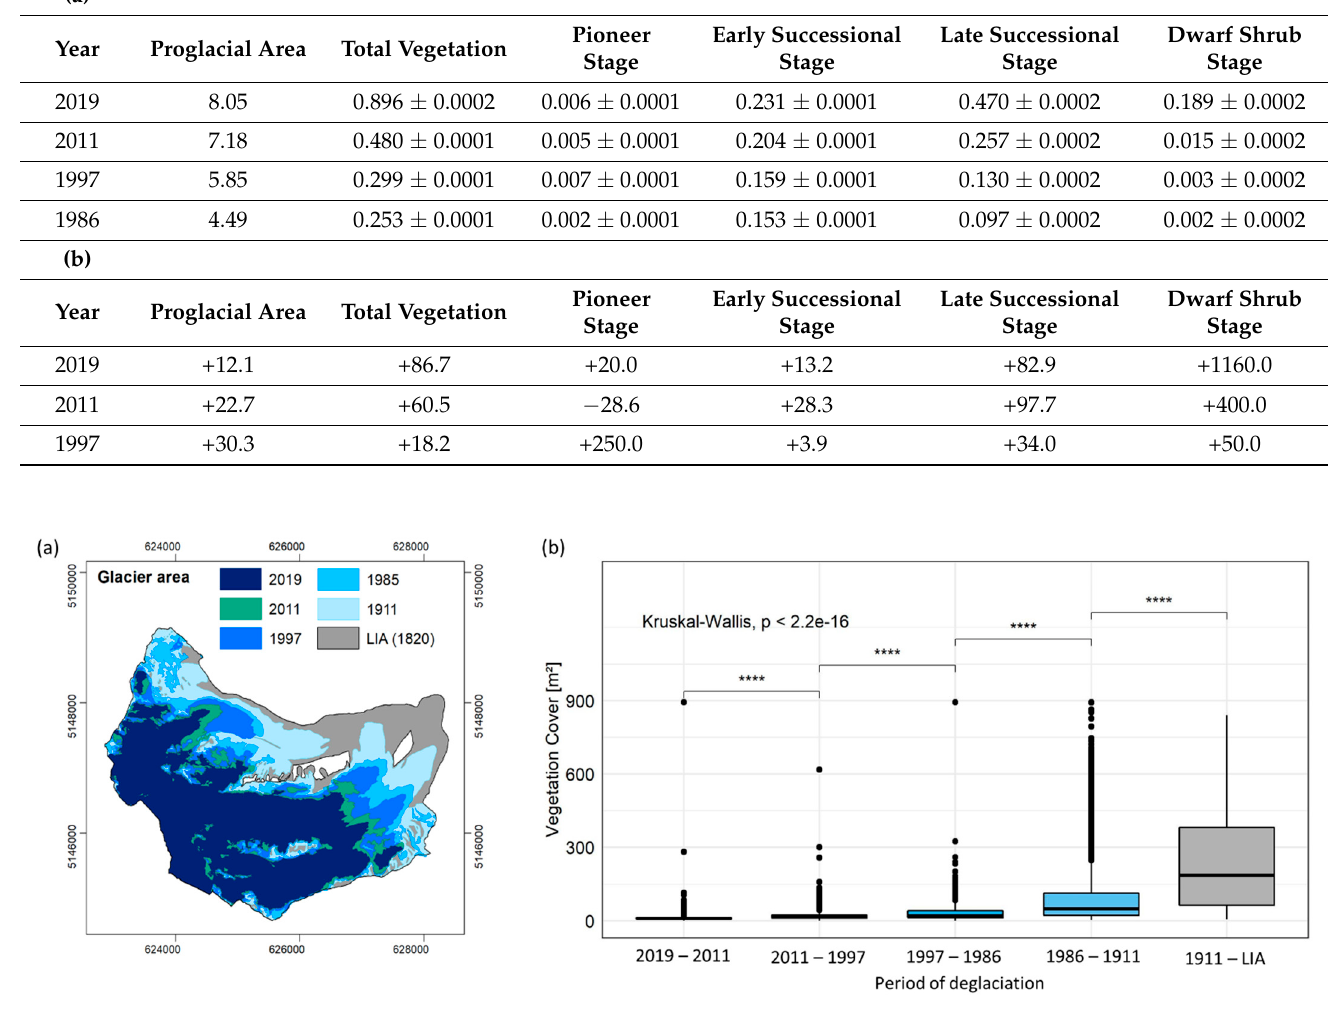
+50.0 The temperature lapse rate, which was determined based on temperature time series of nine weather stations, has a value of − 0.0048 K/m. Figure 5a compares the temperature anomaly (1961–1990) of the long-term time series (20CRv3—20th Century Reanalysis ver- sion 3 data; NOAA; 1836–2015) with the respective elevation change based on the deter- mined temperature gradient. By assuming a temperature increase of +0.4 ± 0.1 °C/decade since the 1980s, the isotherm must have risen by 275 ± 69 m in the study period (1986– 2019). Delayed to this, an increase in the mean height of the proglacial area of 86 m (1985– 2019), induced by the continuous glacier retreat, could be observed. Further, there was a statistically highly significant increase in mean elevation of total vegetation cover from 2772 m a.s.l. to 2858 m a.s.l. (86 m) between 1986 and 2019 (Figure 5e). This identical in- crease in mean elevation agrees well with the in-situ observations, with the first plants being found in the immediate vicinity of the glacier margin and thus on sediments that were ice-free for at most one year. Concerning vegetation with cover values exceeding 15% (late successional and dwarf shrub stage) and hence stages with high percentage of